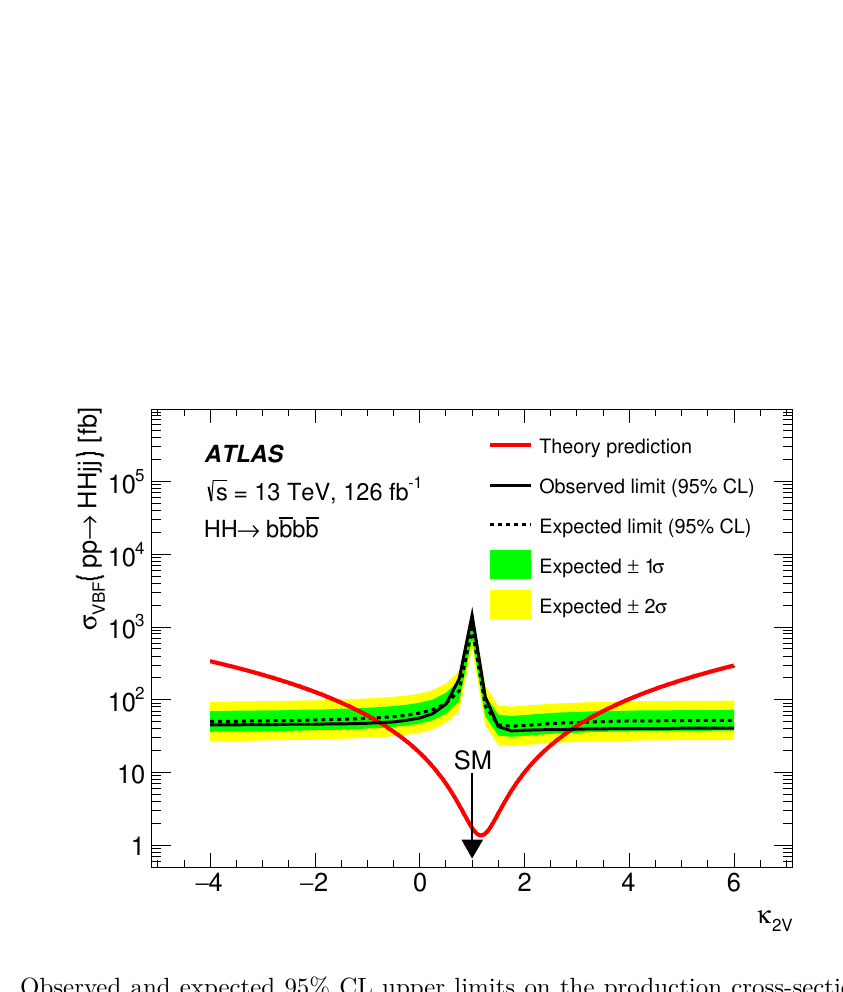
Figure 6 . Observed and expected 95% CL upper limits on the production cross-section for non- resonant HH production via VBF as a function of the di-vector-boson-di-Higgs-boson coupling modifier κ 2 V . The theory prediction of the cross-section as a function of κ 2 V is also shown. More details on the predicted cross-section can be found in section